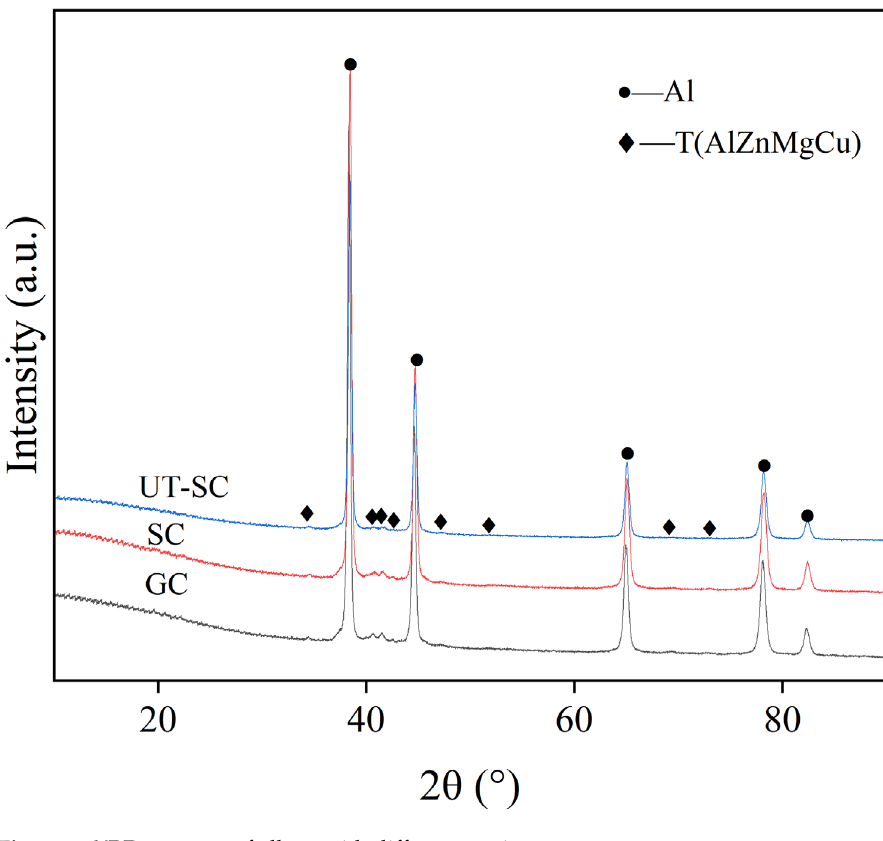
Figure 8. XRD patterns of alloys with different casting processes.